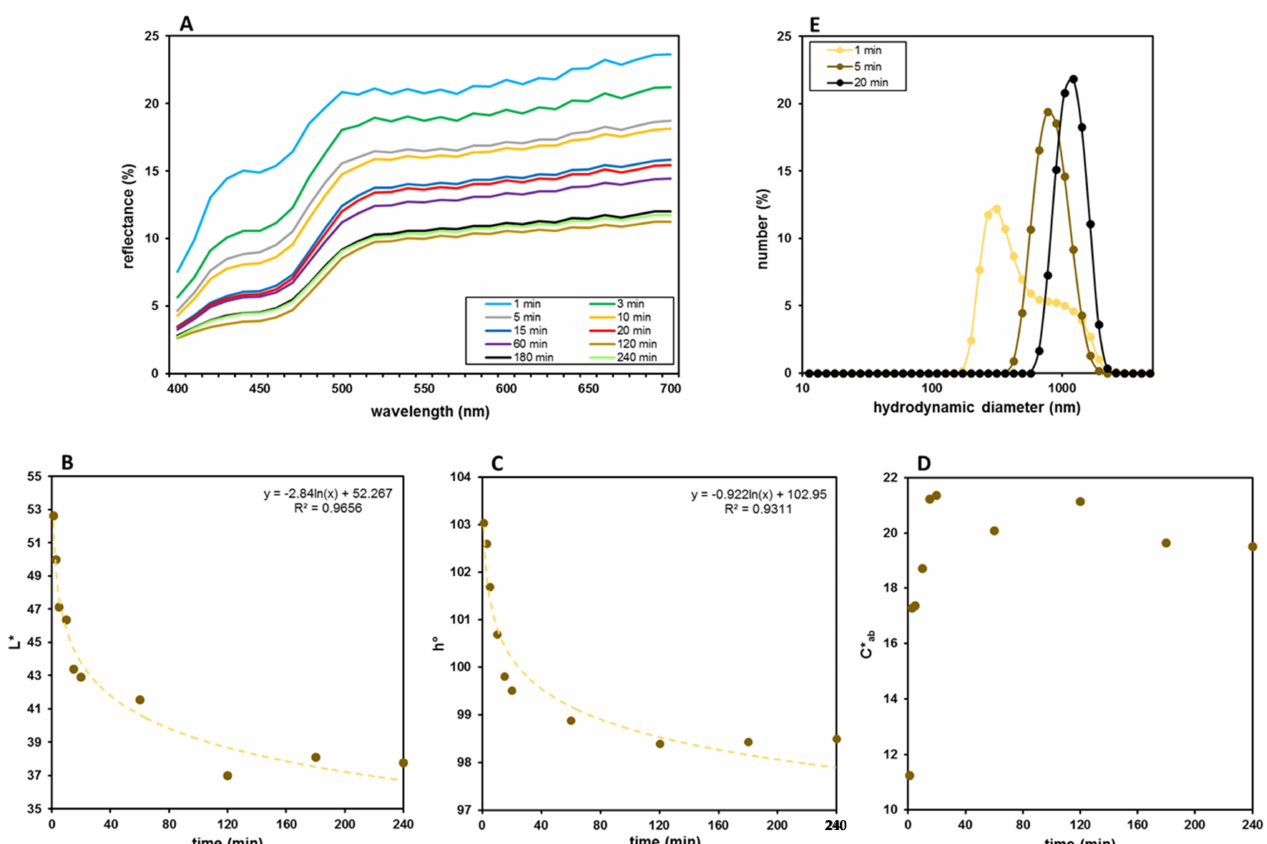
Figure 6. Release of AgNPs in PB (pH = 7.4) from F 40 films evaluated by colorimetric and DLS analyses of the release medium over time. ( A ) Reflectance curves recorded at different time points. Trends of ( B ) L*, ( C ) h ◦ and ( D ) C* ab values. ( E ) Hydrodynamic diameter of released AgNPs measured at three different and representative time